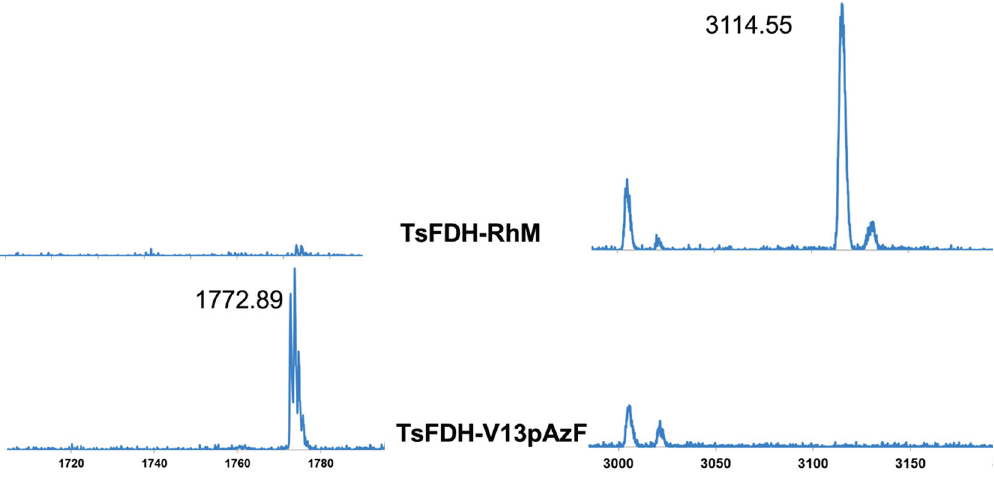
Figure 4. Verification of the RhM conjugation by MALDI-TOF MS. Spectra of TsFDH-RhM ( Top row ) and TsFDH-V13pAzF ( Bottom row ). See the main text for more